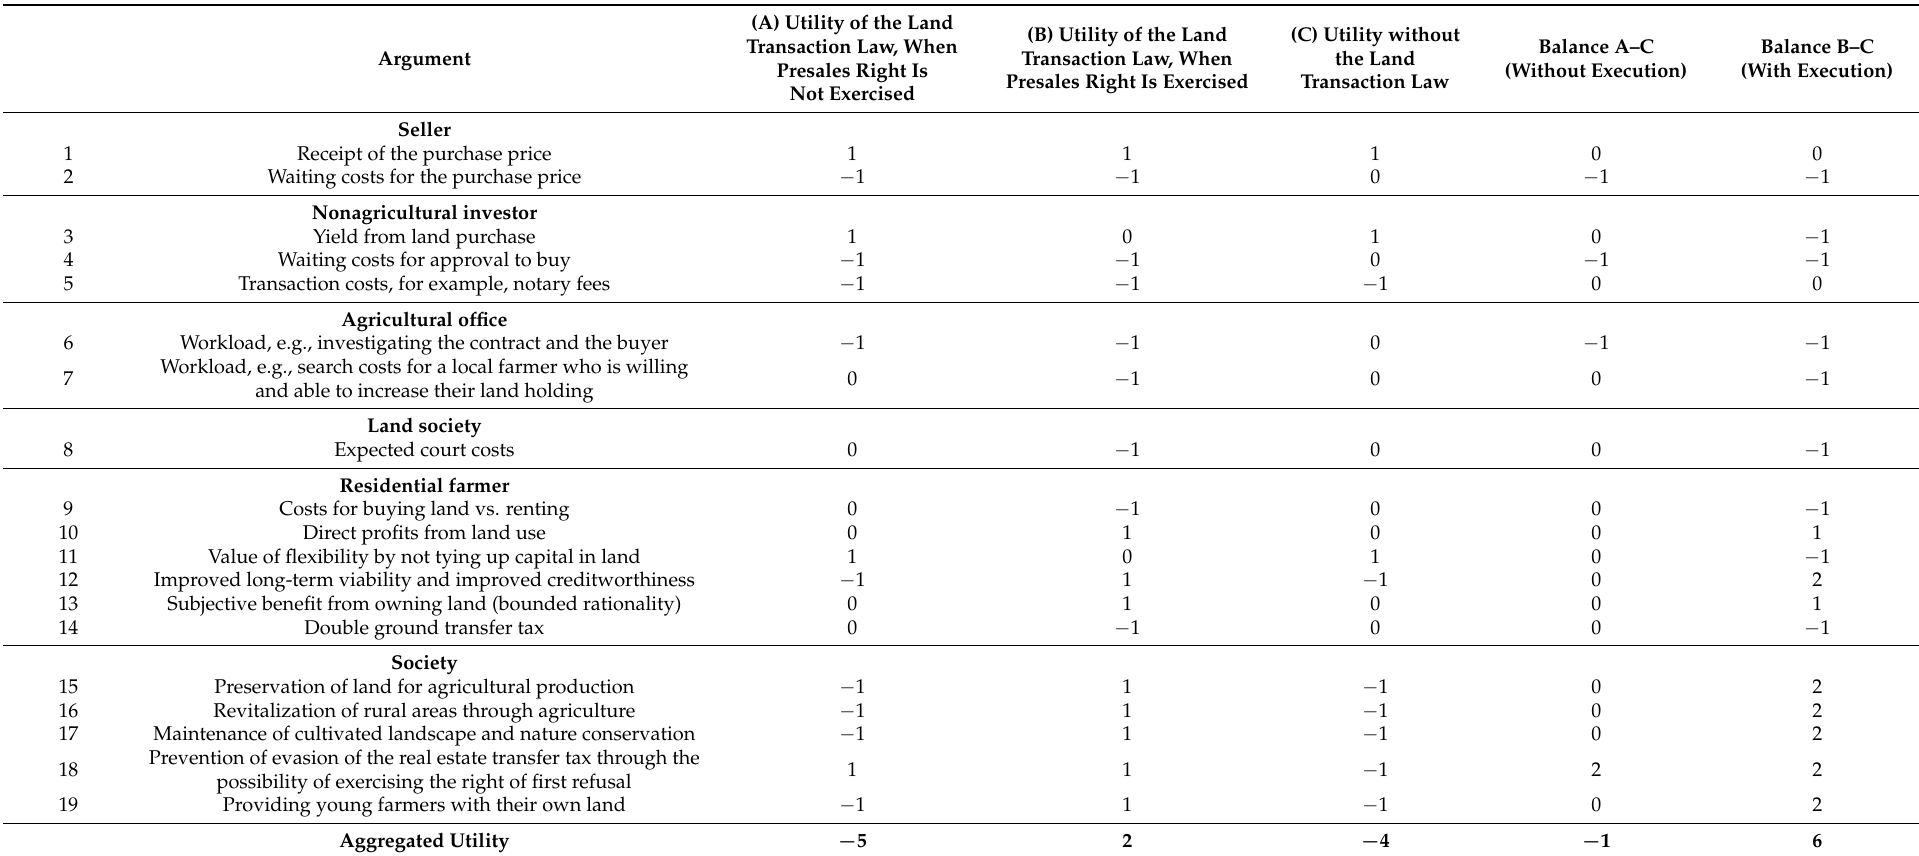
Table 1. Analytical framework with suggested argument weightings relating to the land transaction law from the perspective of a politician working toward the public